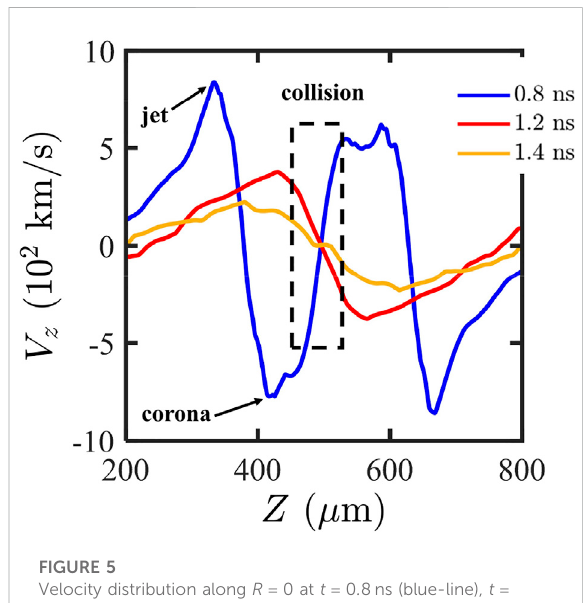
FIGURE 5 Velocity distribution along R (cid:2) 0 at t (cid:2) 0 . 8ns (blue-line), t (cid:2) 1 . 2ns (red-line), and t (cid:2) 1 . 4ns (orange-line). The dashed square denotes the collision area and the arrows denote the jet and corona plasma at t (cid:2) 0 . 8ns.